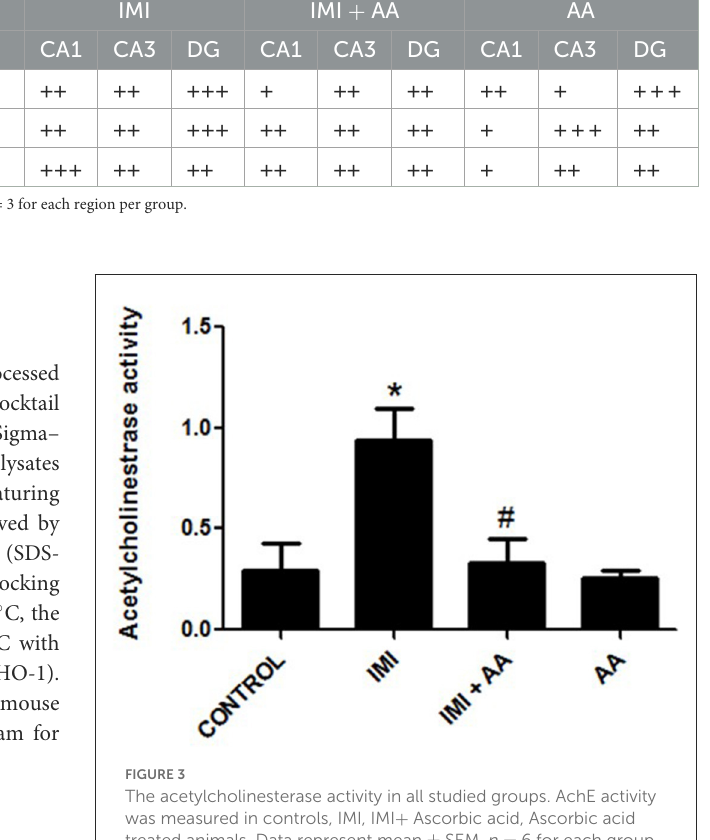
TABLE 1 Histopathological score of hippocampus regions (CA1, CA3, and dentate gyrus) in control, IMI, IMI + AA, and AA. Group Control Region parameter Neuronal degeneration